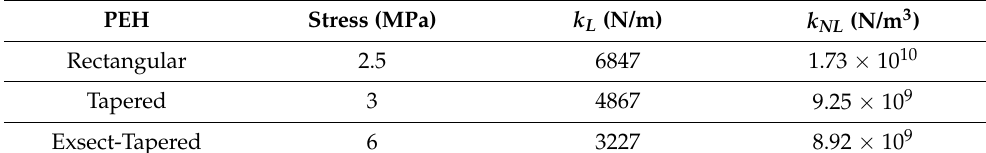
Table 2. Comparison of stiffness and stiffness coefficients of different PEHs.